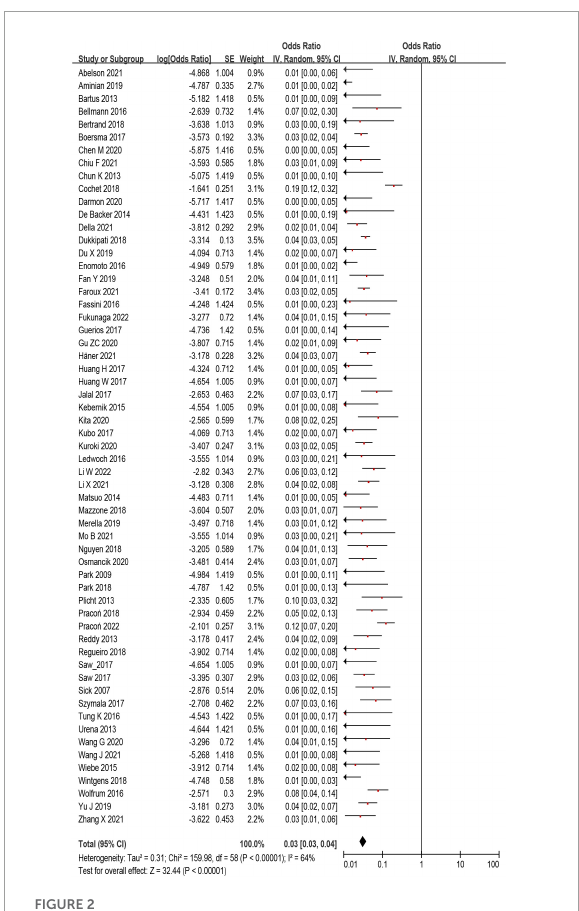
FIGURE2 The forest plot of the device related thrombus (DRT) incidence after left atrial appendage closure (LAAC) of all eligible studies. The odds ratio represents the incidence of